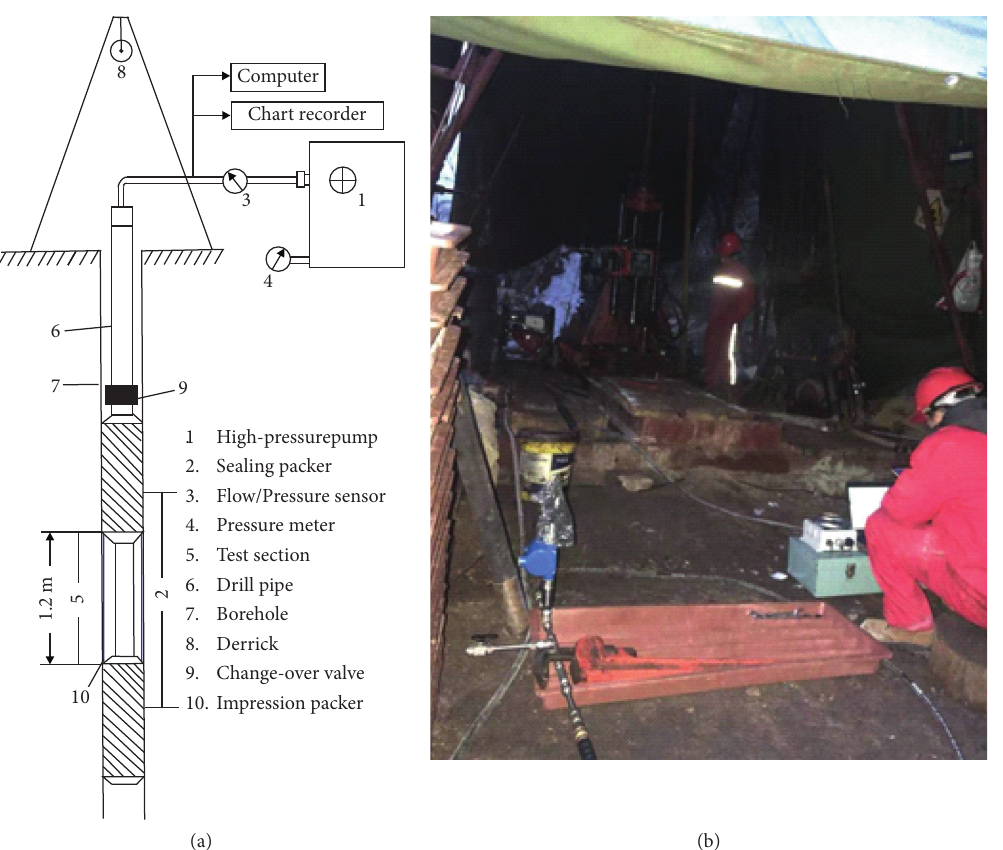
Figure 2: Hydraulic fracturing measurement method. (a) Schematic diagram with the hydraulic fracturing equipment; (b) field photograph of the measurement